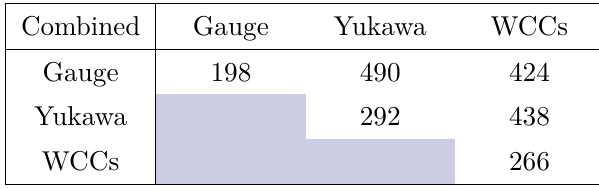
Table 3 . The number of independent constraints on the β -function coefficients obtained from combining various sets of